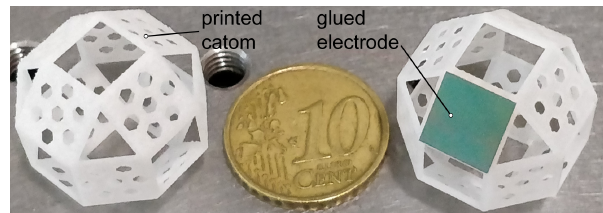
Figure 7. Printed catom’s structure and catom with glued electrode.